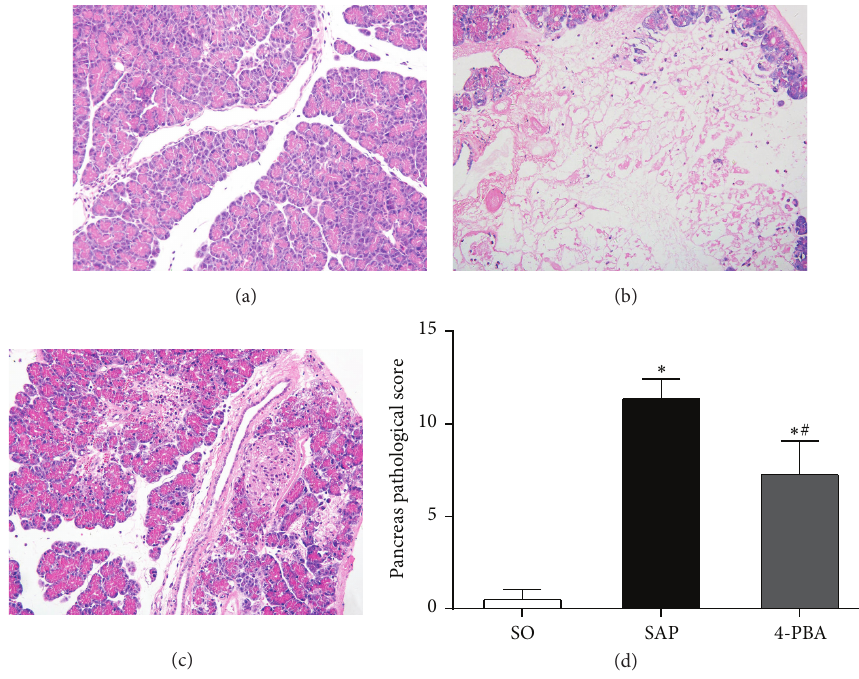
Figure 2: Morphologic changes in pancreatic tissue at 12 hours and pancreatic histopathological scores in all groups of rats. Representative hematoxylin and eosin-stained sections were examined by light microscopy (original magnification, × 200). (a) Sham-operation (SO) group; (b) severe acute pancreatitis model (SAP) group; (c) 4-PBA treatment (4-PBA) group. (d) Comparison of the total pathological scores of the pancreas in all groups. Each value represents the mean ± standard deviation. ∗ 𝑃 < 0.05 versus SO group; # 𝑃 < 0.05 versus SAP